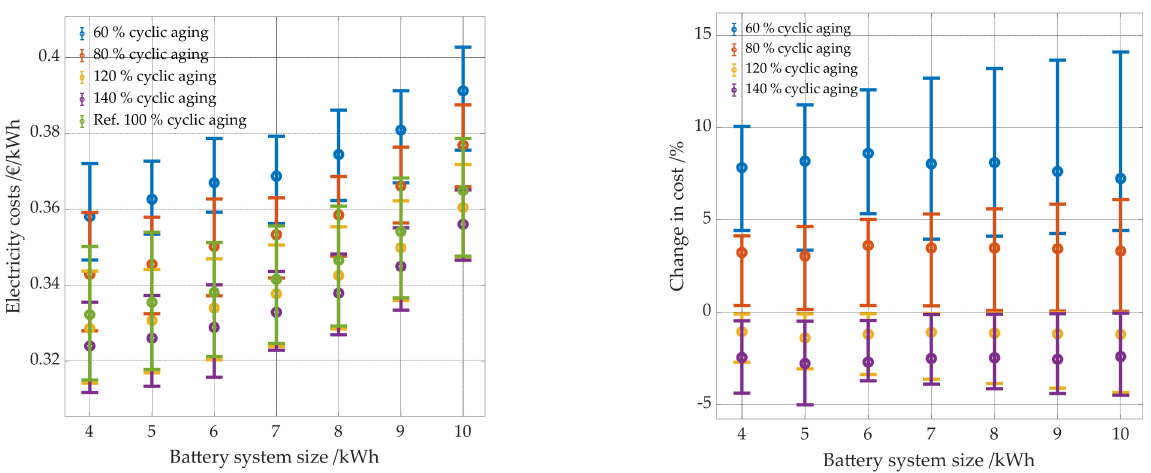
Figure 24. Electricity costs per kWh as a function of battery system size ( left panel) and the change in cost as a function of battery size ( right panel). The results for different degrees of cyclic aging are shown in color. The reference case is shown in